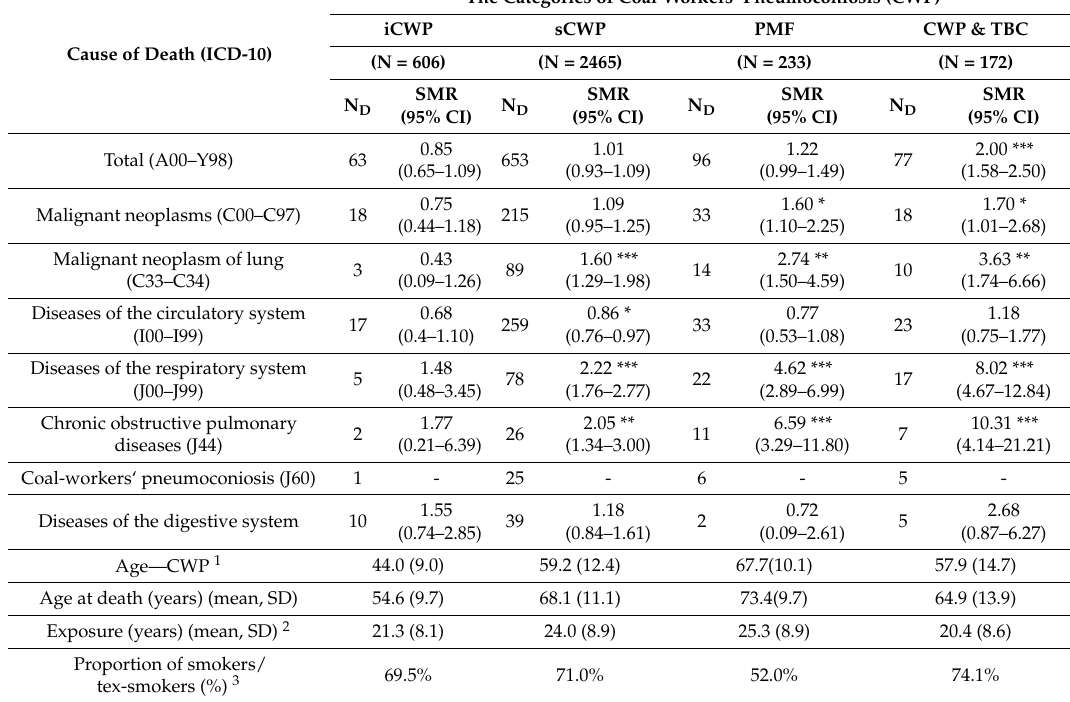
Table 4. The comparison of total and specific mortality in black coal miners with the acknowledged coal-workers’ pneumoconiosis (CWP) and mortality of the general male population in the Czech Republic in the period 1992–2013 according to the severity of